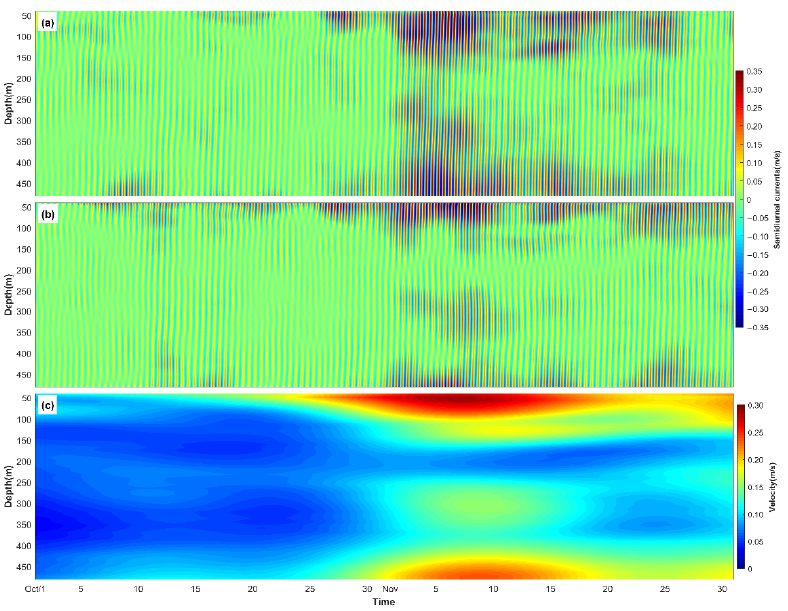
Figure 6. ( a ) Along-isobath, ( b ) cross-isobath semidiurnal internal tidal currents and ( c ) low-pass filtered amplitude of semidiurnal internal tidal velocity from October to November in 2017. The low-pass filter has a cutoff frequency of 1/30 cpd.